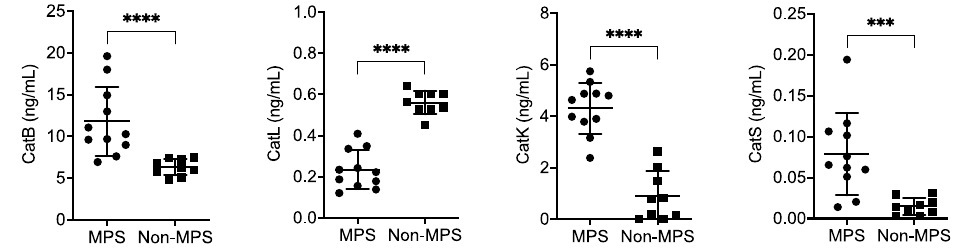
Figure 3. Human cathepsins levels in MPS and non-MPS respiratory specimen. Respiratory specimens, including sputum and tracheal aspirates were collected from MPS patients (N = 11, with 2 MPS-I, 5 MPS-II, and 4 MPS-III) and non-MPS patients (N = 9). Clinical features of patients included in the study were detailed in a previous report [58]. Samples were aseptically weighed and instantly diluted at 1 g/10 mL in a preservative buffer (final concentrations: 100 mM sodium acetate, pH 5.0 plus the peptidase inhibitors 0.5 mM PMSF, 0.5 mM EDTA, 40 µM pepstatin A, and 1 mM MMTS). Samples were then centrifuged for 10 min at 5000× g at 4 °C, and the resulting cell-free supernatants were collected, aliquoted, and stored at − 80 °C. The total protein quantification of supernatants was performed by BCA assay (ThermoFisher Scientific, Illkirch, France). Protein levels of cathepsins B, L, S, and K (CatB, CatL, CatS, and CatK, respectively) were performed using specific ELISA kit (R&D Systems Europe, Abingdon, UK; and Novus Biologicals, Bio-Techne SAS, Noyal Chatillon Sur Seine, France). Assays (duplicate) were repeated at least three independent times. Statistical analyses were performed using Mann–Whitney U test (***: p < 0.001; ****: p < 0.0001).